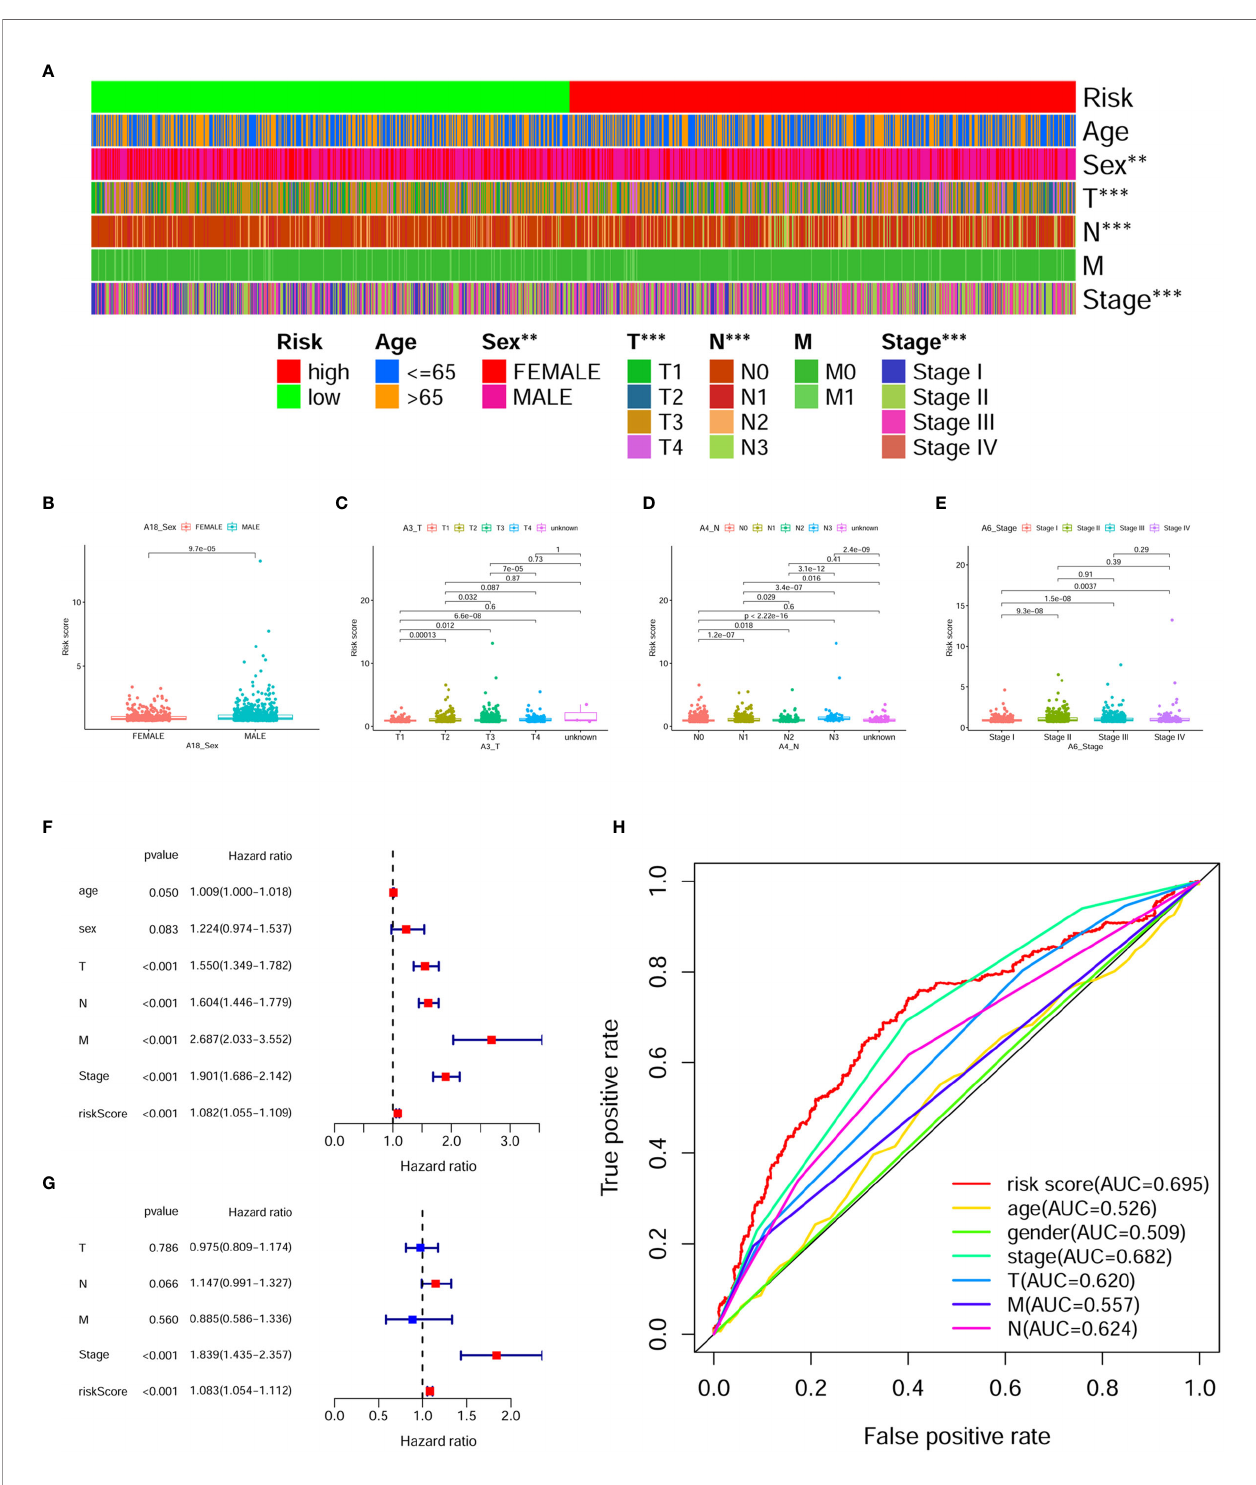
FIGURE 5 | Assessing the relationship between clinicopathological characteristics and prognostic models. (A) The bar chart illustrates it remarkably correlated the risk score with sex, T stage, N stage, and clinical stage. (B – E) The scatterplot shows that (B) sex, (C) T stage, (D) N stage and (E) clinical stage are signi fi cantly associated with risk score. (F) The risk score, clinical stage, T stage, N stage, and M stage were signi fi cantly associated with clinical prognosis in digestive system pan-cancer by the univariate cox analysis. (G) The risk score and clinical stage as independent prognostic factors for digestive system pan-cancer according to the multivariate cox analysis. (H) The ROC analysis based on the risk score and clinicopathological features demonstrated that the AUCs for both risk scores (0.695) and clinical staging (0.682) were greater than